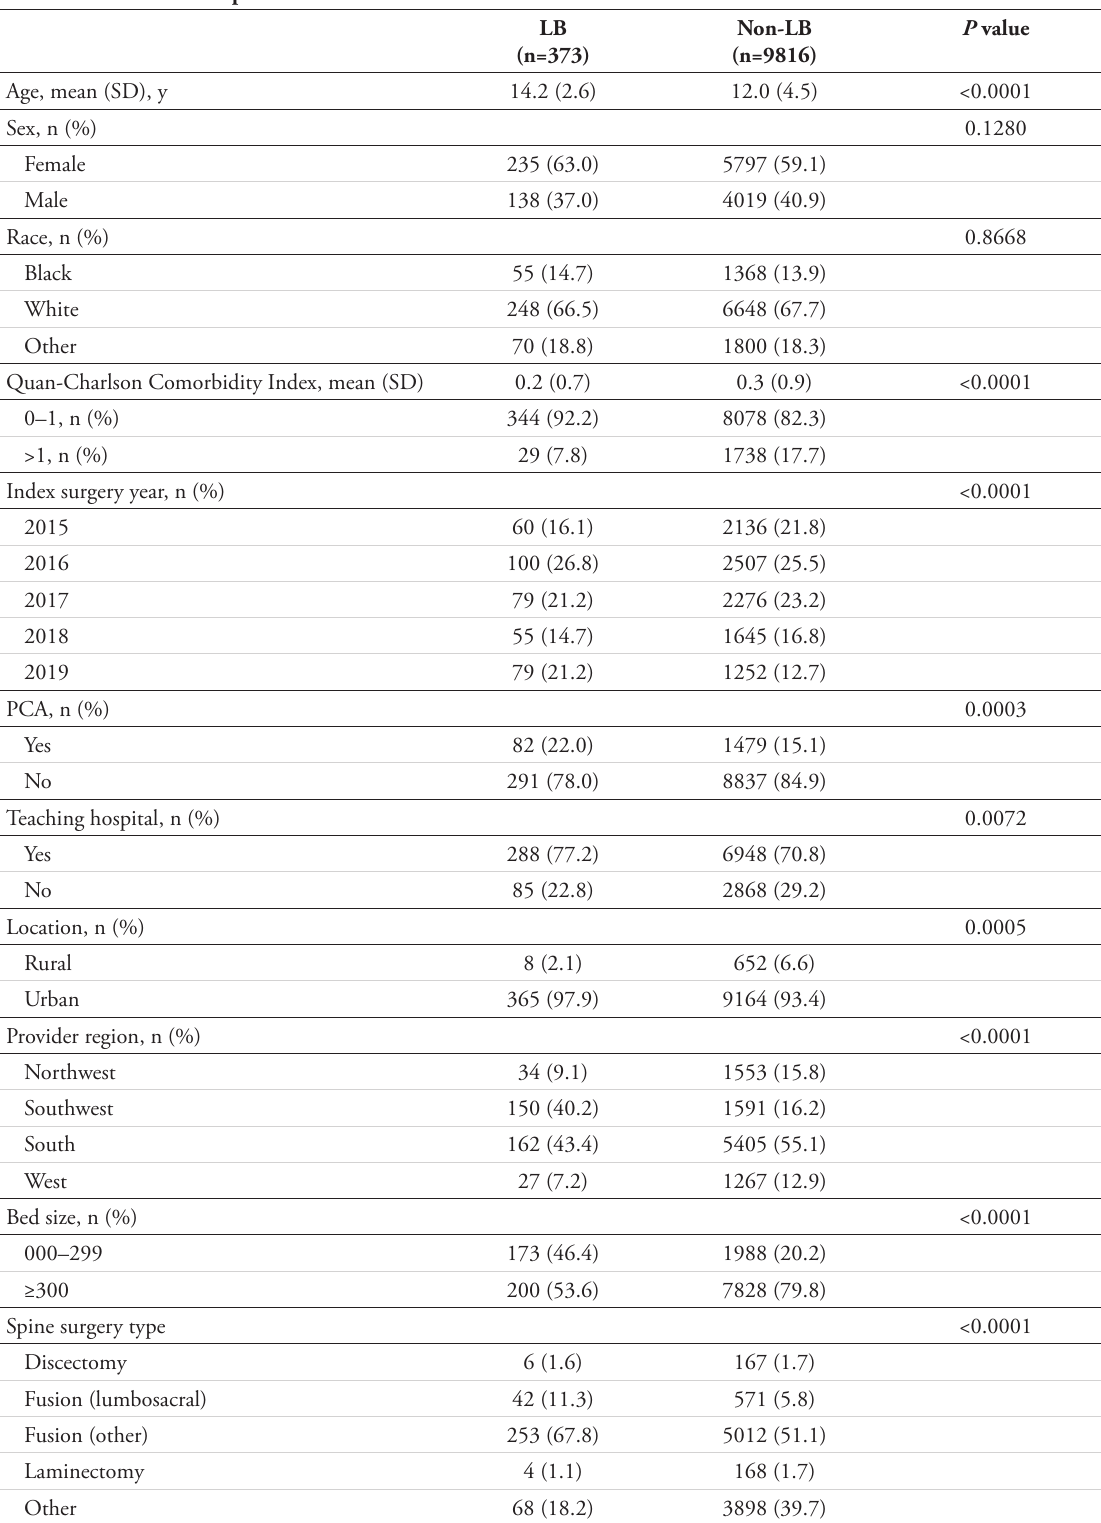
Table 1. Patient and Hospital